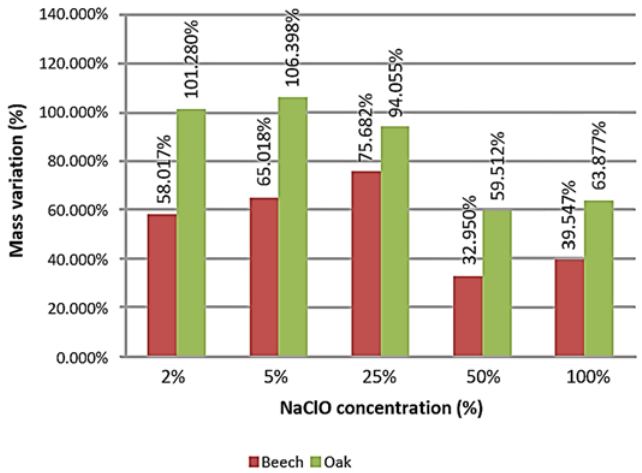
Figure 5. Mass variation of the small samples after three weeks of immersion.